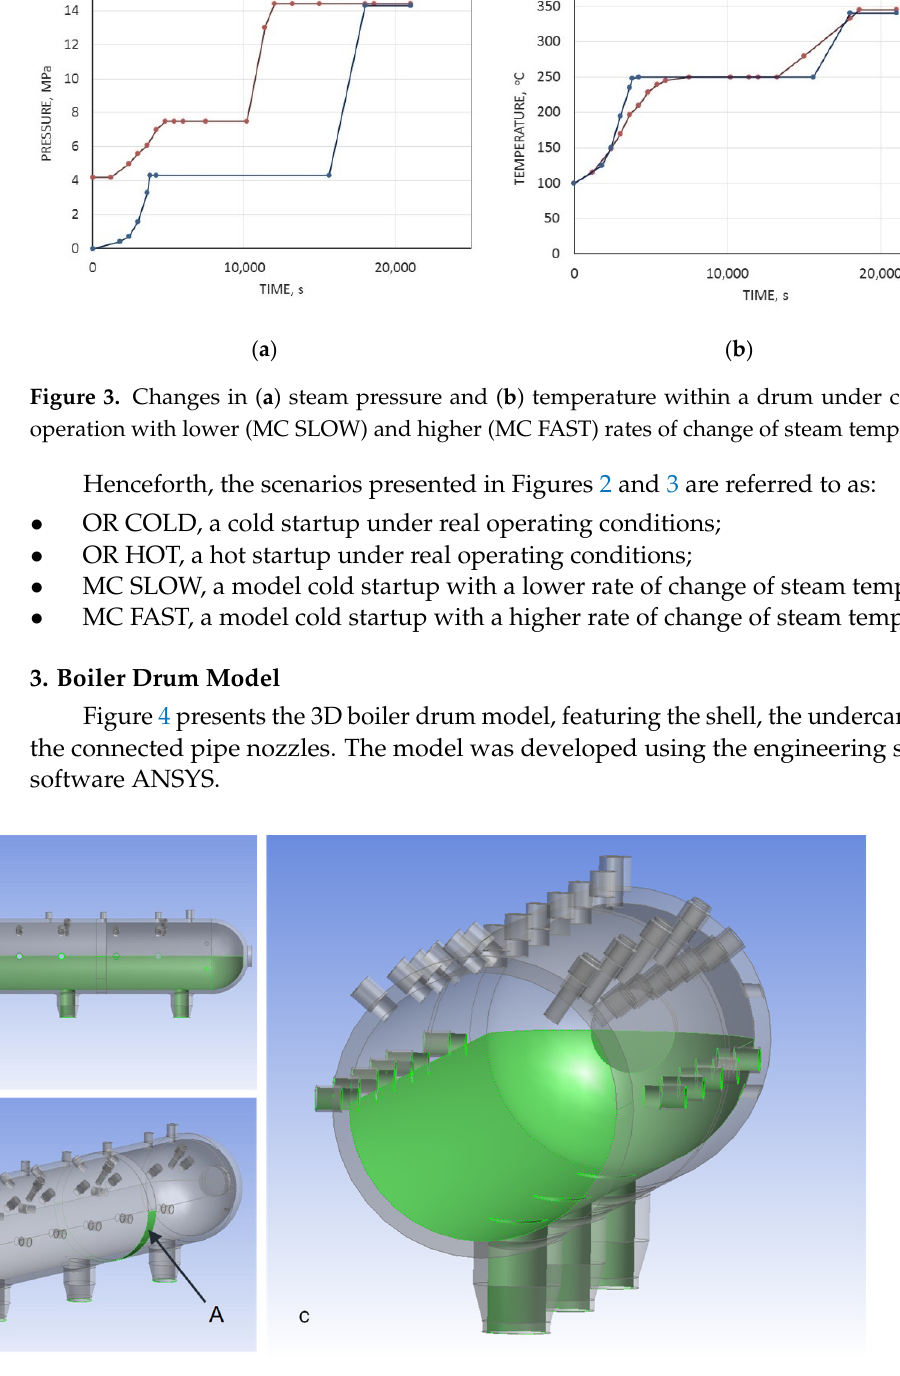
operation (OR COLD) and hot startup operation (OR HOT), when subjected to real industrial con-